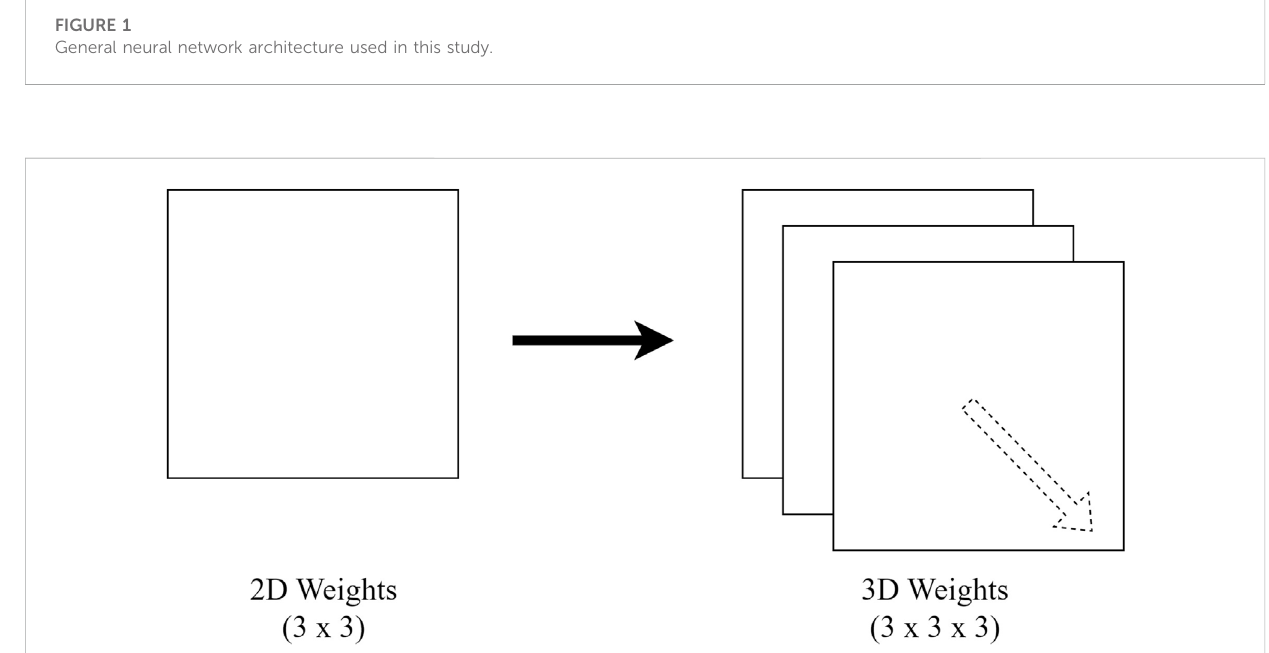
FIGURE 2 Replication of 2D weights along the third